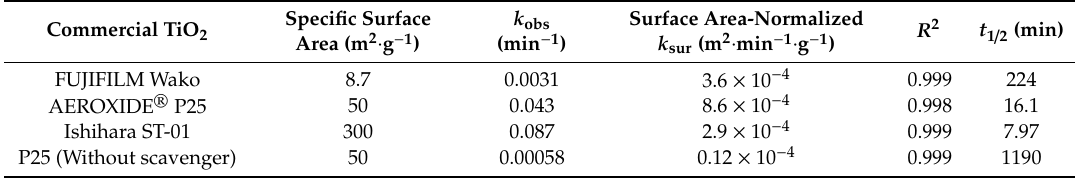
Table 1. Kinetic parameters for the photocatalytic reduction of